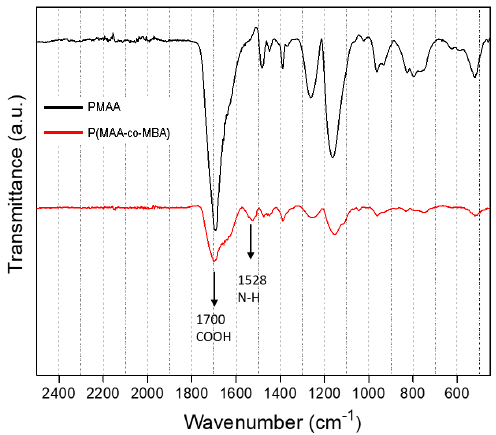
Figure 2. FT-IR spectra of PMAA and P(MAA-co-MBA) microspheres.